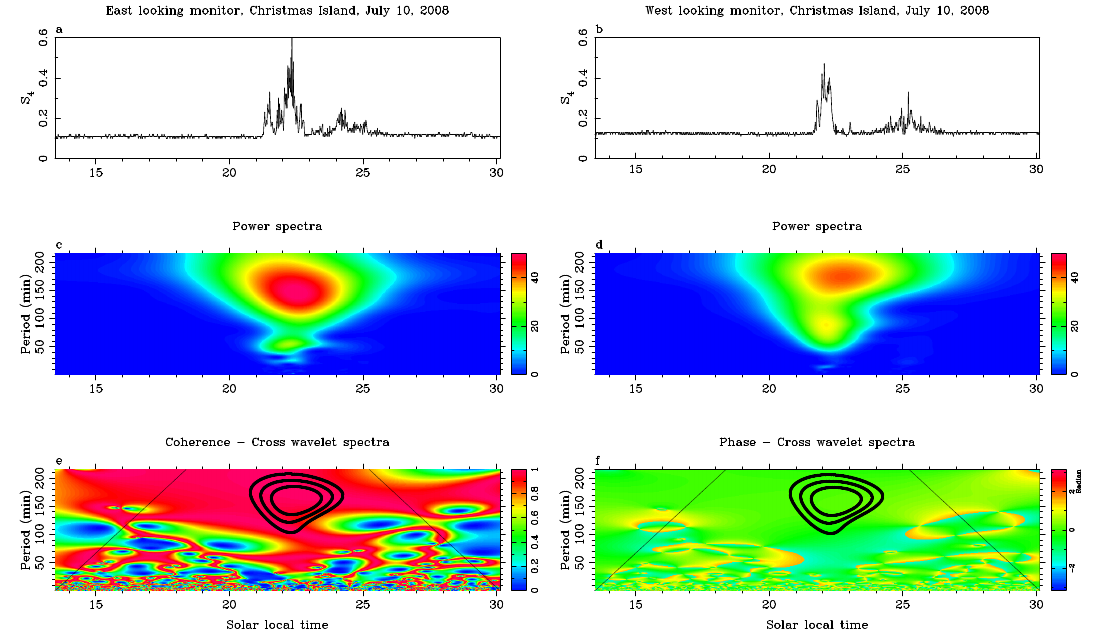
Fig. 2. (a) S 4 for the east-looking monitor on 10 July 2008, (b) S 4 for the west-looking monitor on 10 July 2008, (c) power spectra (normalized by signal variance) for the signal in (a) , (d) power spectra (normalized by signal variance) for the signal in (b) , (e) coherence of cross-wavelet transform for the east- and west-looking monitors, and (f) phase